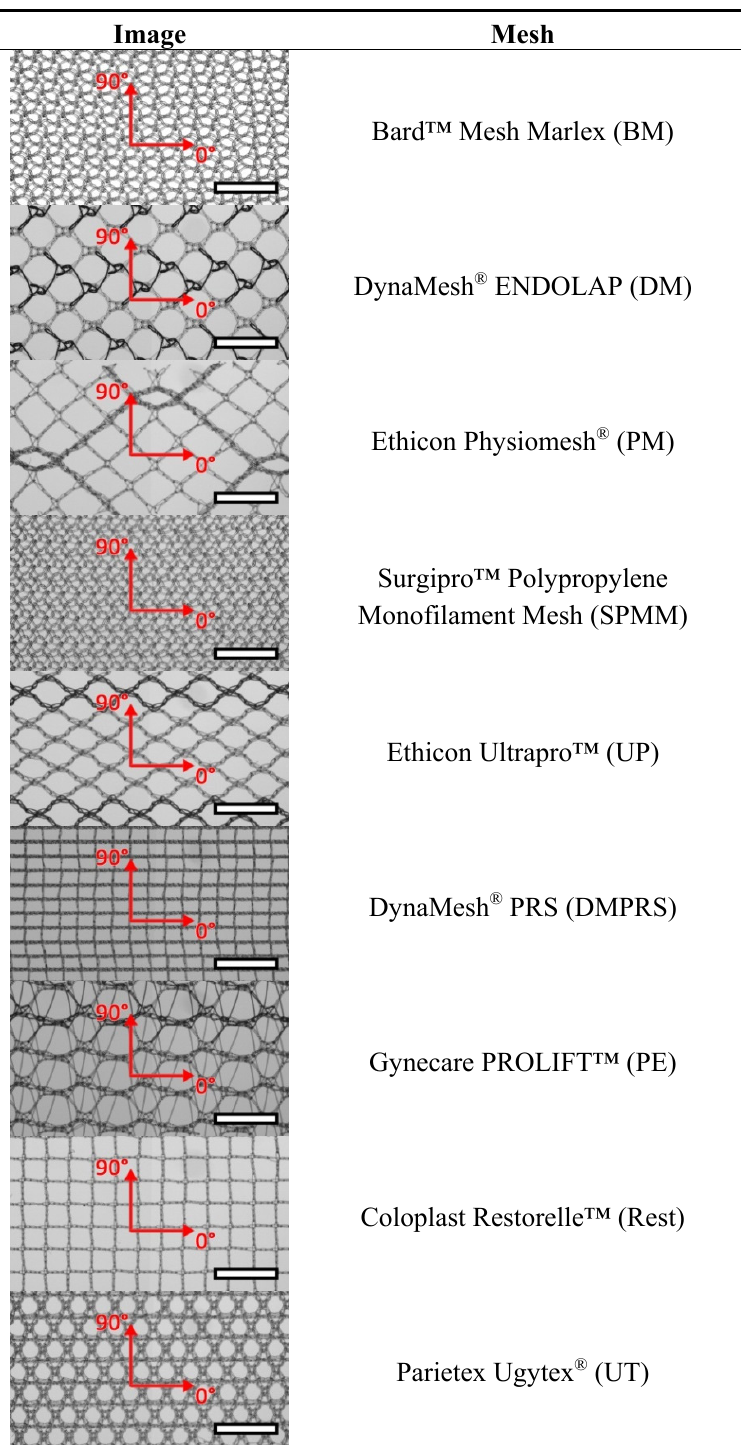
Table 1. List of mesh types used for the present investigation, with their weight classified as ultralight, light or standard according to [24]. Principal directions of testing are marked in red. Scale bar (lower right): 5 mm. Their clinical application is listed as pelvic organ prolapse (POP) or hernia repair, as specified by the